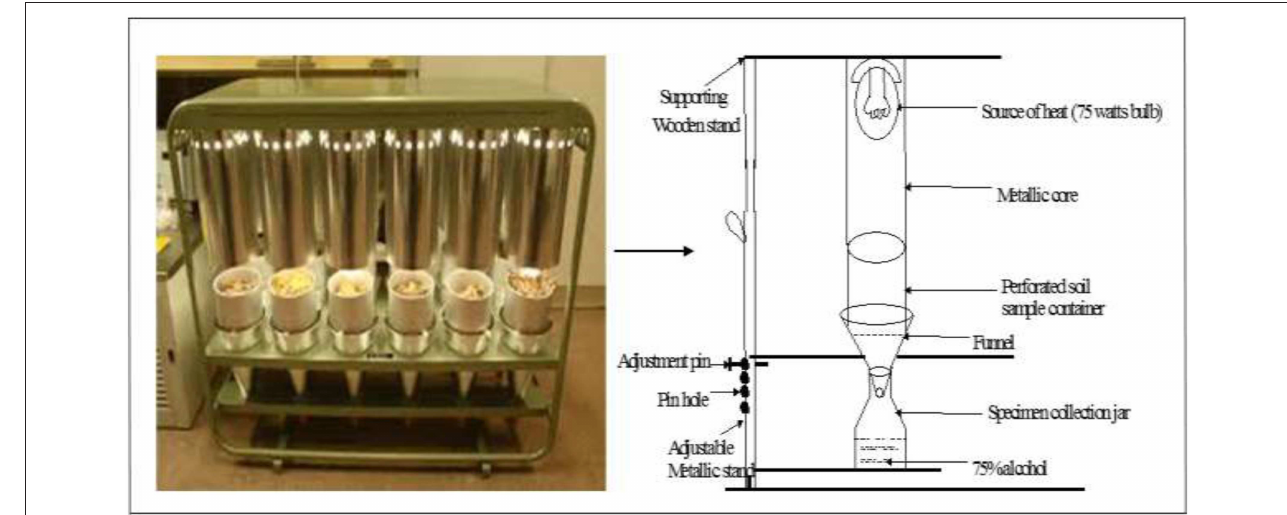
PLATE 3 | Photo and sketch diagram showing the Berlese-Tullgren